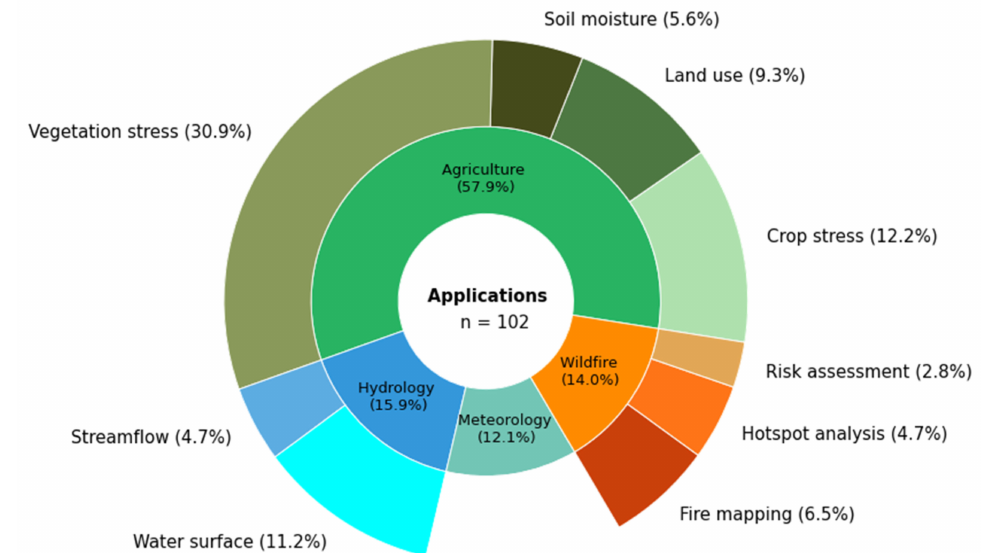
Figure 13. The summary of drought applications in four major domains with ten subcategories, including crop stress, land use change, soil moisture, vegetation stress, streamflow and water surface variability, fire mapping, fire hotspot analysis, fire risk assessment and other-related